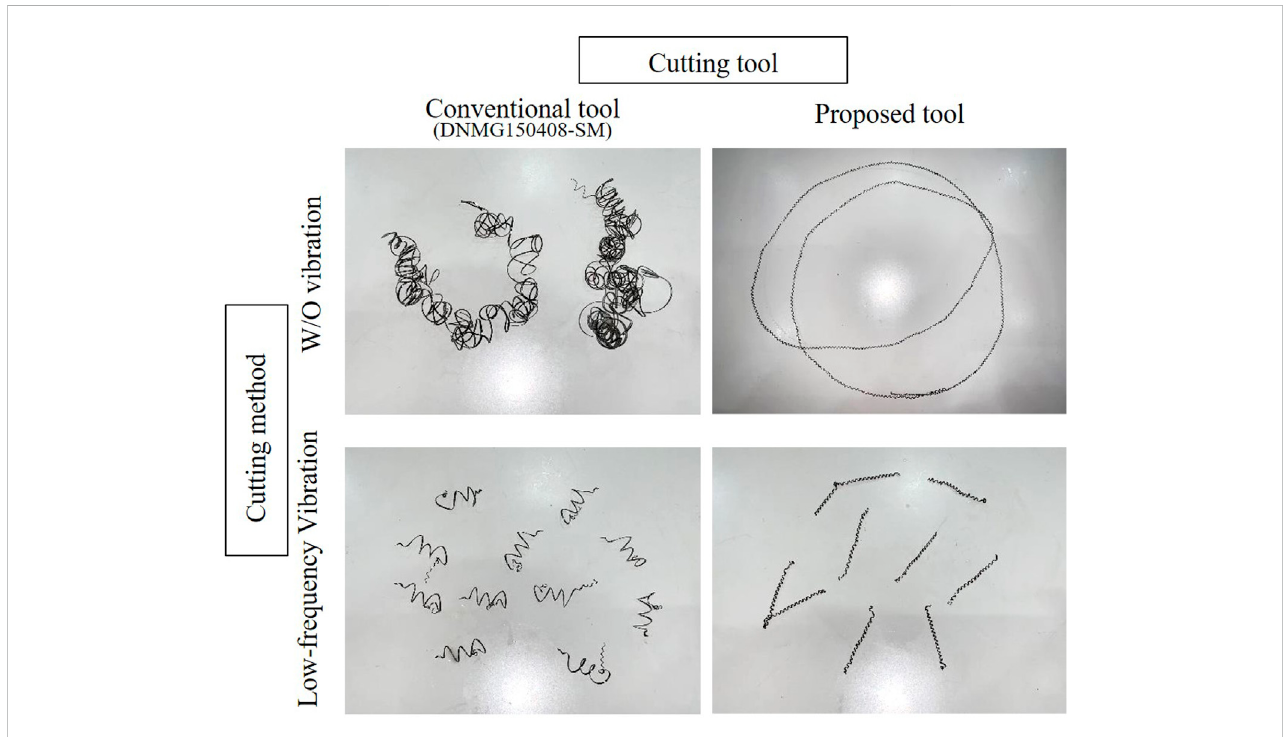
FIGURE 11 Cutting chips ( I = .5 and K = 1.5 for vibration-assisted